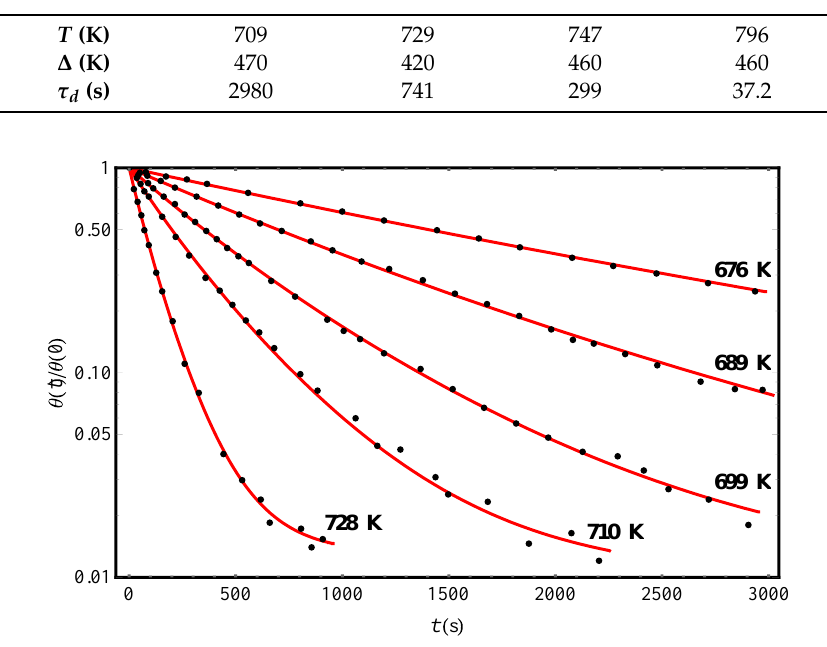
Figure 3. The experimental temporal dependences (points, [11]) of the reduced hydrogen coverages θ ( t )/ θ ( 0 ) of the Si(100)2×1 adsorbent at different temperatures and the initial condition θ ( 0 ) = 0.15. The solid (red) curves represent the theoretical processing of the data [11] by Equation (13) with parameters Δ, c , and d pointed out in Table 2. Table 2. The results of theoretical processing of experimental data [11] on the kinetics of hydrogen desorption from the Si(100)2×1 surface at different temperatures and the initial condition θ ( 0 ) = 0.15 (Figure 3). The values of the characteristic parameters d , Δ, and c were found by approximating the data [11] according to Equation (13) with the use of the least squares method.